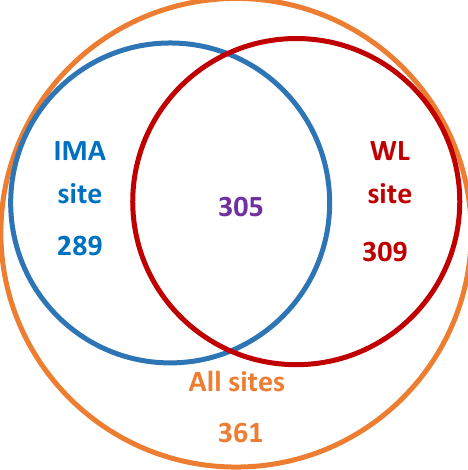
Figure 3. Venn diagram showing the number of Barcode Index Numbers (BINs) collected at each of the two continuously monitored sites, compared against the overall diversity observed. IMA — CHARS Intensively Monitored Area north of Grenier Lake; WL — Water Lake north of Cambridge Bay.